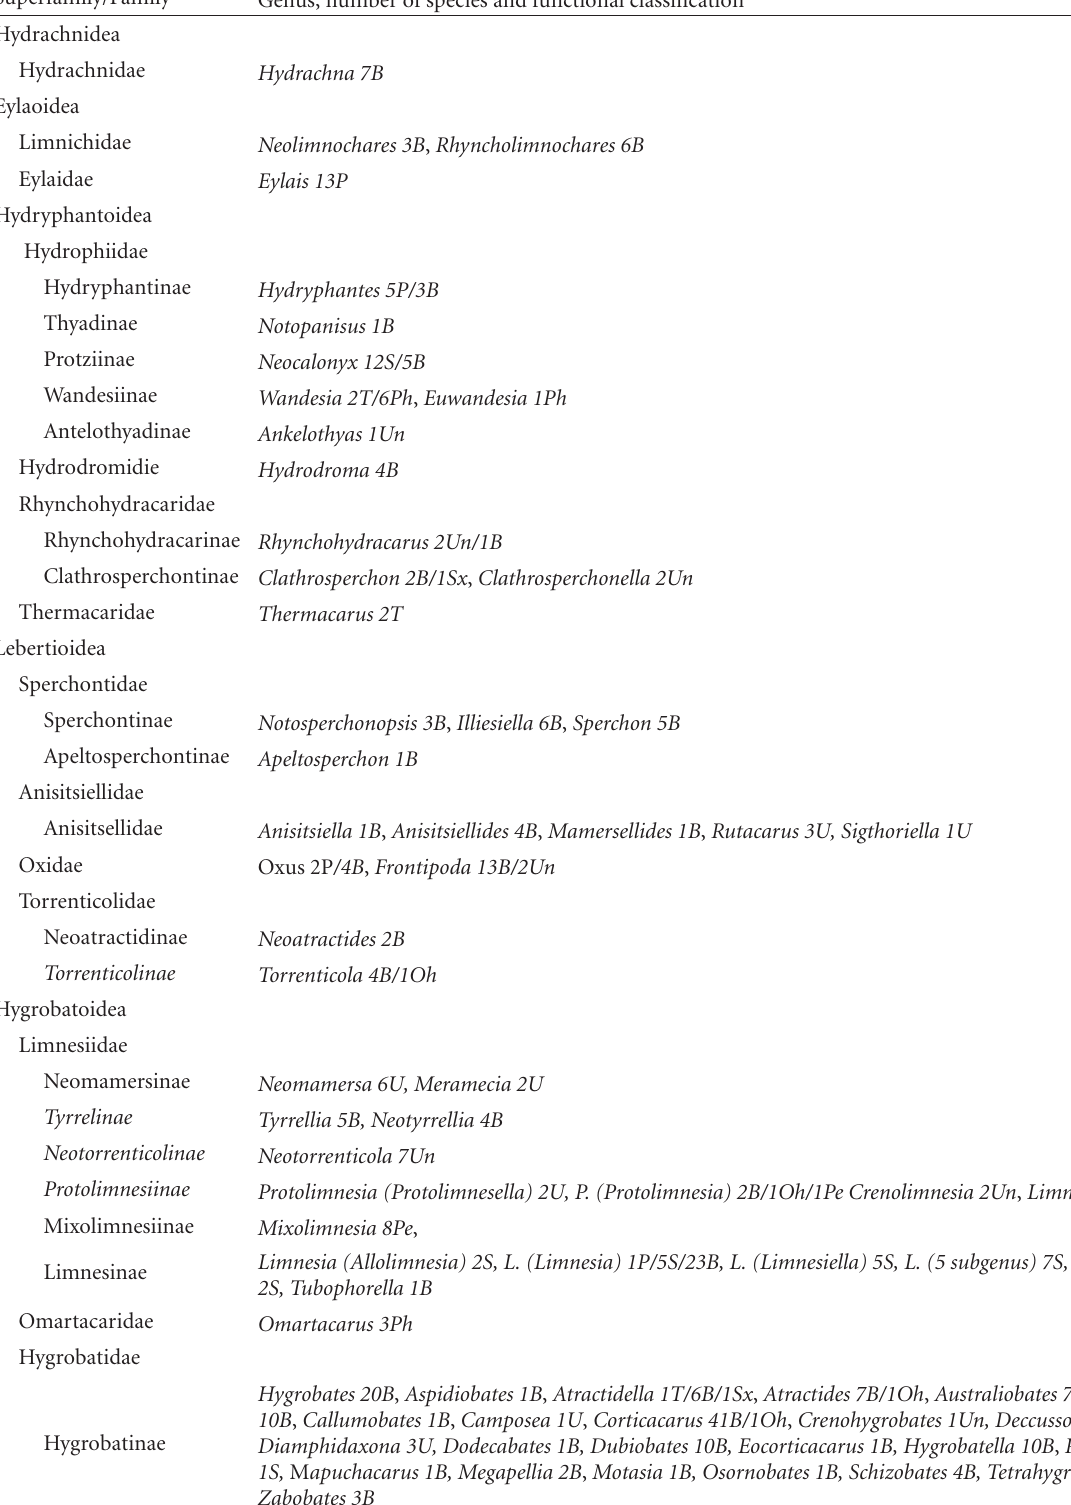
Table 1: Taxonomic list of Hydrachnidia present south of latitude S 15 in South America (modified from Rosso de Ferrad´as and Fern´andez, 2005), with numbers of species indicated as well as functional classification. Un—Unknown, T—Thermal, P—Planktonic, S—Superficial, B—Benthic, Sx—Stygoxene, Oh—Occasional hyporheos, Pe—Permanent hyporheos, U—Ubiquitous stygobite, Ph—phreatobyte.